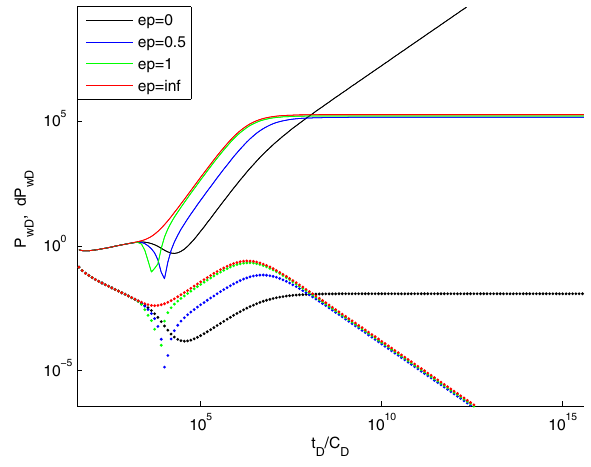
on the characteristic Γ